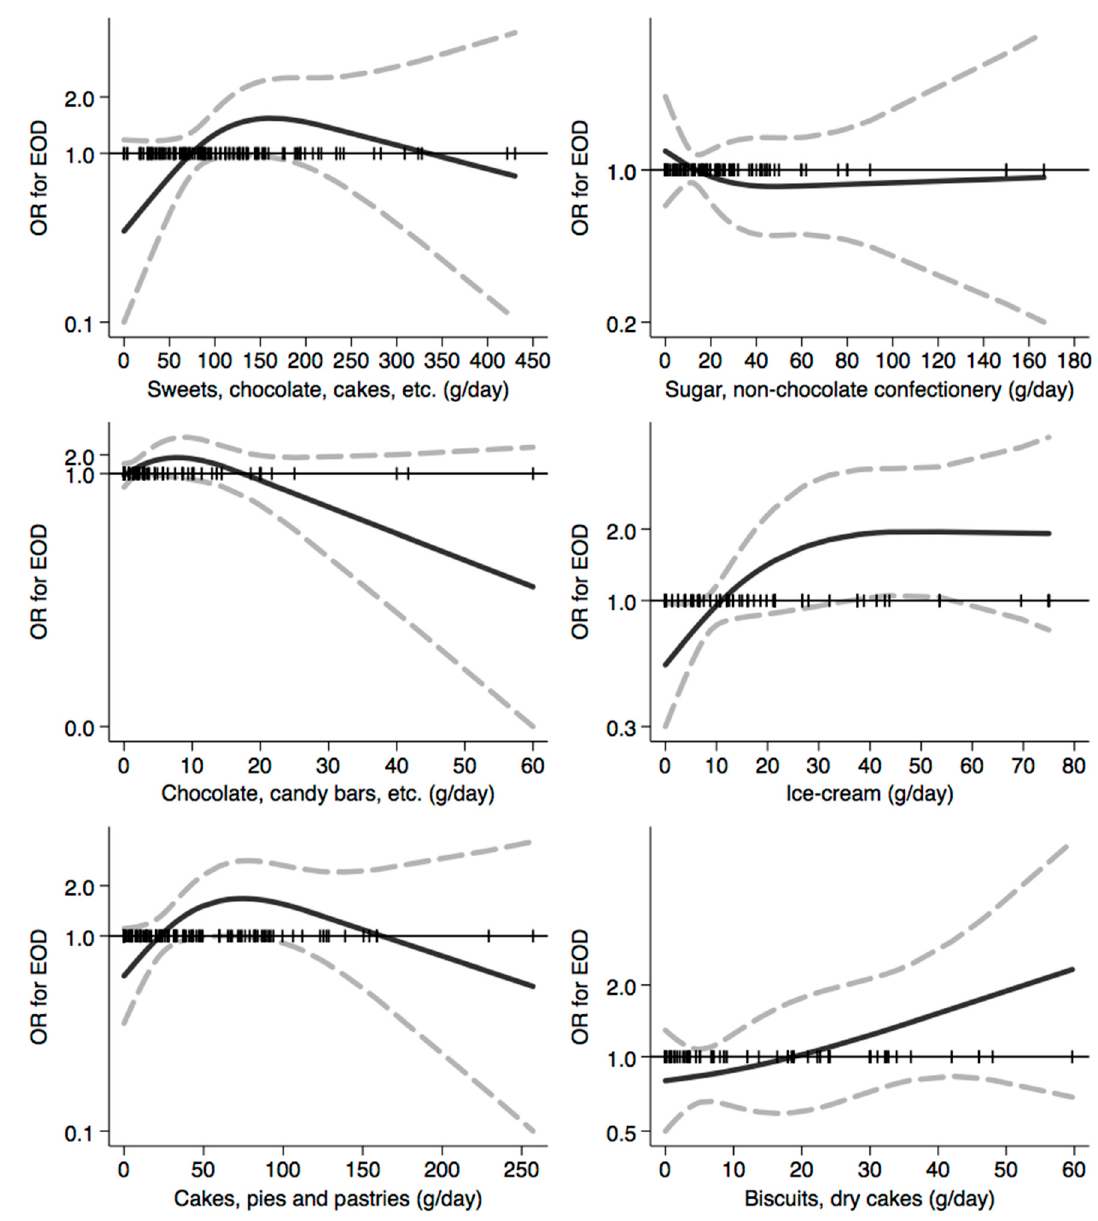
Figure 8. Spline regression analysis of early-onset dementia (EOD) risk for increasing intake of sweets products. The black line indicates odds ratios for dementia risk; dash gray lines are 95% confidence limits; the reference line at 1.0 with black spikes indicates the distribution of participant intake.